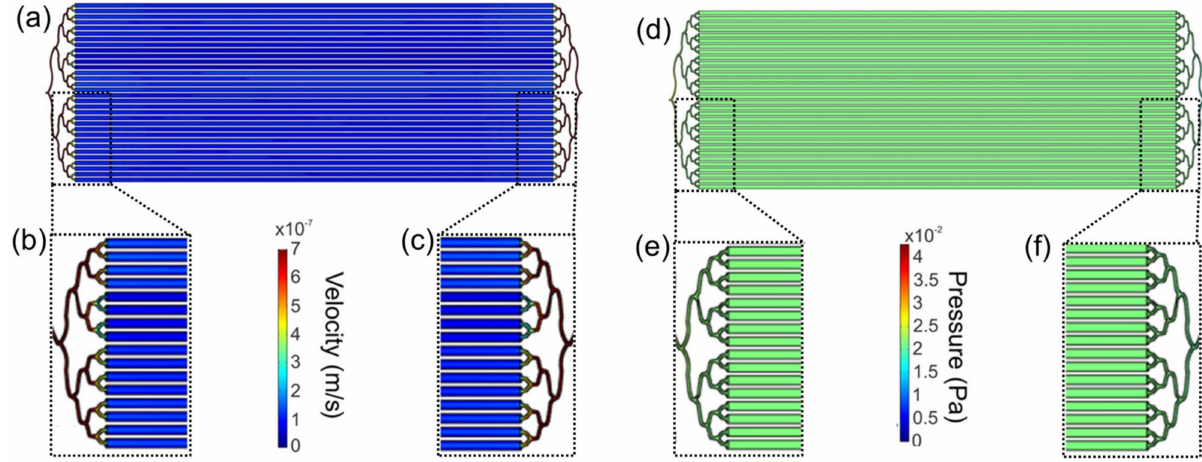
Figure 3. Computational modeling of the flow in the large-area microfluidic bioreactor. Variable velocity (m/sec) in ( a ) the whole design ( b ) inlet and ( c ) outlet of the chip. Pressure (Pa) in ( d ) the whole design, ( e ) inlet and ( f ) outlet of the chip. The simulations were created in the microchannels at a height of 75 µ m. Figures generated from an arbitrary input stream 1 × 10 − 8 m 3 /s (600 µ